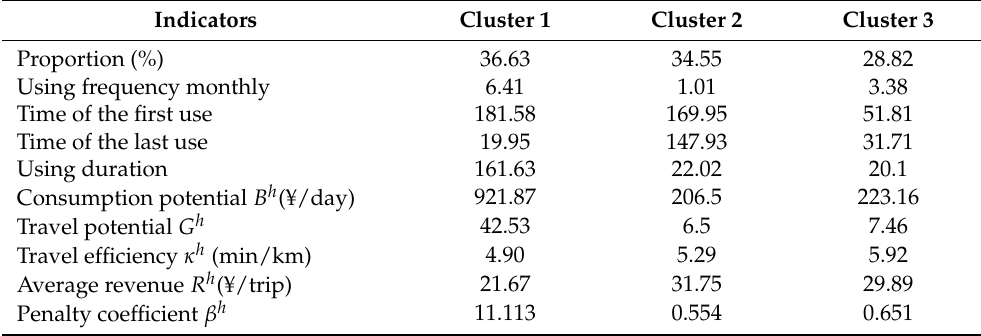
Table 1. Details about the indicators for different user